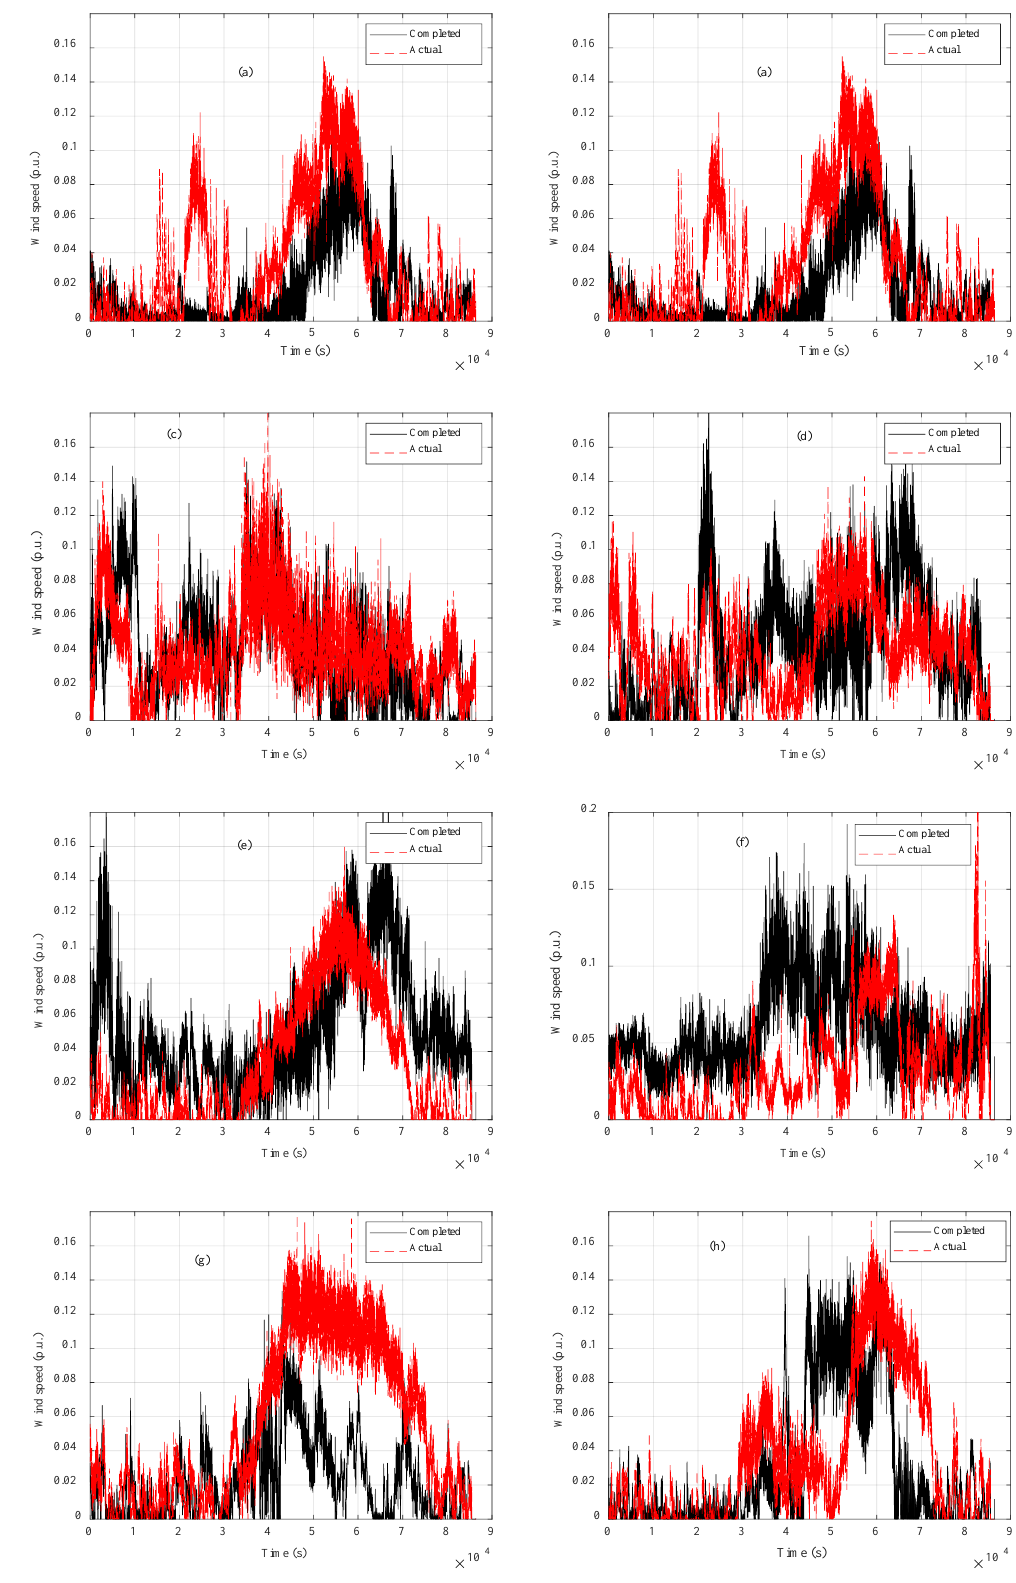
Figure 13. Completed and actual data of: ( a ) 01/10/2012; ( b ) 09/11/2012; ( c ) 09/01/2013; ( d ) 01/02/2013; ( e ) 23/04/2016; ( f ) 16/05/2013; ( g ) 09/06/2013; ( h ) 15/07/2013. The clustering was held with the K-means